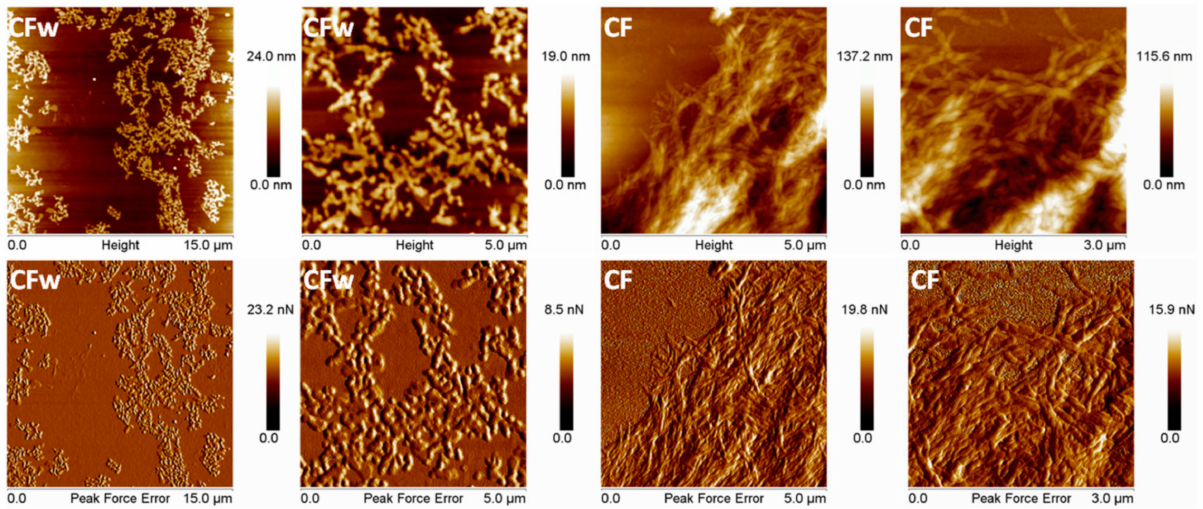
Figure 1. Topographic and PFE images with different magnification of CFw and